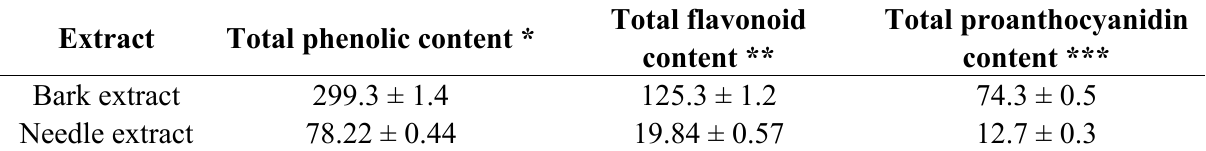
Table 1. Total phenolic, flavonoid and proanthocyanidin contents in Pinus cembra L.